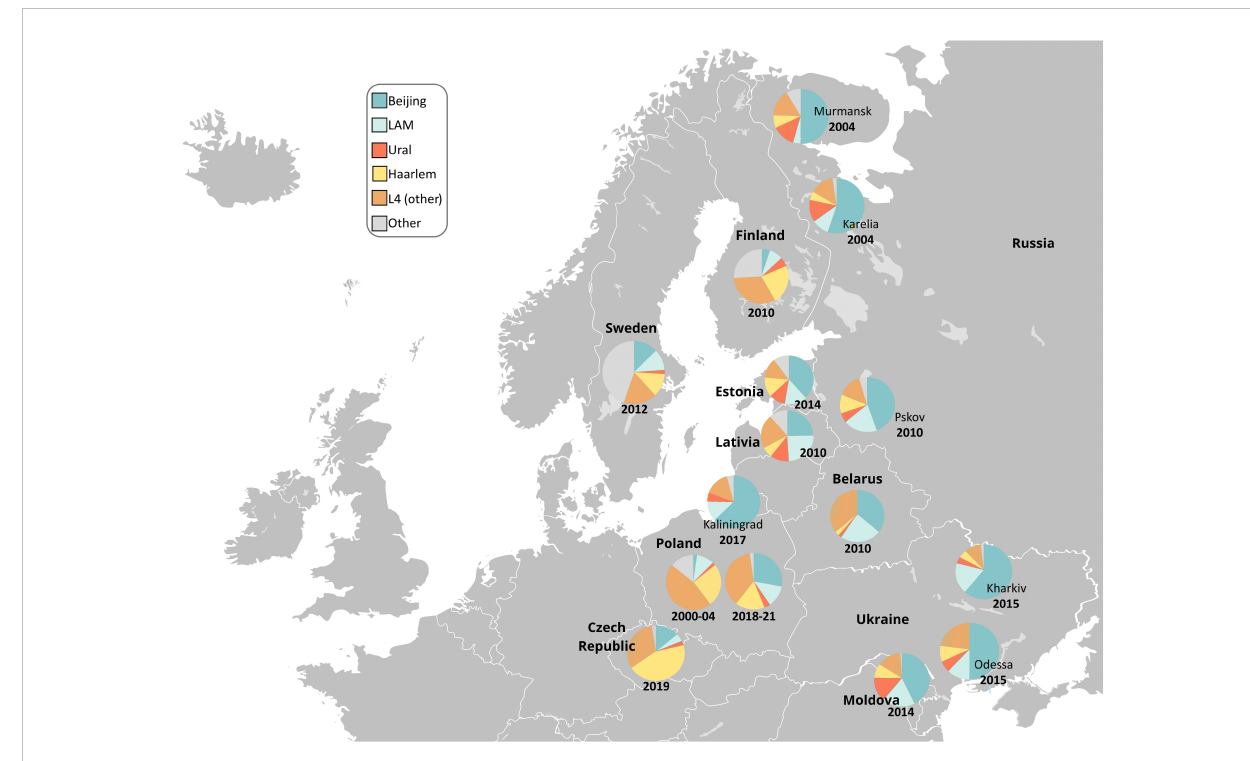
FIGURE 3 Geographic distribution of the main M. tuberculosis families in Poland and Northern and Eastern Europe. Free map available at: https:// pl.m.wikipedia.org/wiki/Plik :